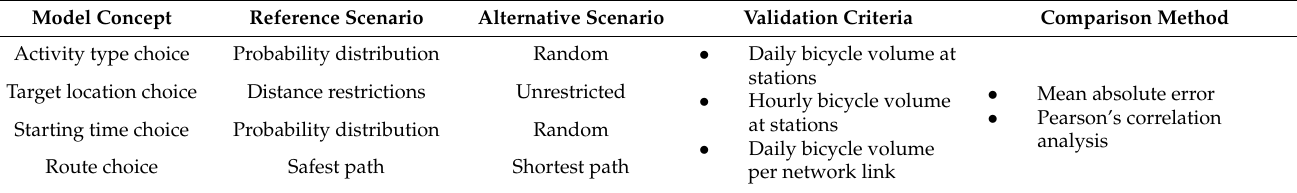
Table 4. The alternative scenarios of model concepts with concept descriptions, evaluation criteria, and comparison methods. Model